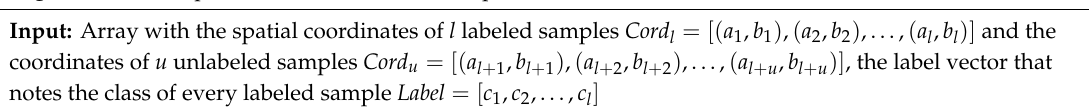
Figure 2. A graphical illustration of the CASD algorithm. ( a ) The raw dataset with A~F six samples, where A, F are the labeled samples with the same class and the rest are unlabeled samples to be predicted. The subscript below each sample shows its pixel location in the hyperspectral data. ( b ) Construct a complete undirected graph where each vertex represents a sample and the edge between every two samples is weighted by their Euclidean distance. ( c ) A and F are the labeled samples with the same class, so reweight the edge between them by zero. ( d ) For every two vertices, compute the shortest path between them (the shortest path between A and C is marked in magenta). ( e ) Update the weight between every two vertices with the length of the shortest path between them. The new edge weight is called “the class adjusted spatial distance”. Algorithm 1 Compute CASD for each two samples